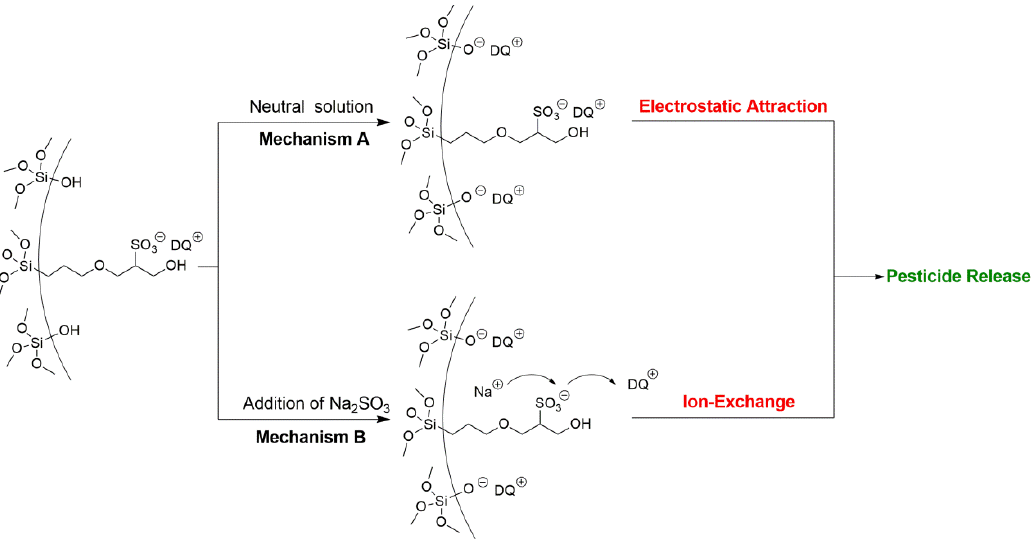
Figure 7. Schematic illustration of the controlled-release mechanism of a cationic herbicide DQ loaded in negative-charge functionalized MSNs. Mechanism A: pesticide released by electrostatic interaction under different pH solution. Mechanism B: Pesticide released through ion-exchange by increasing the ionic strength.